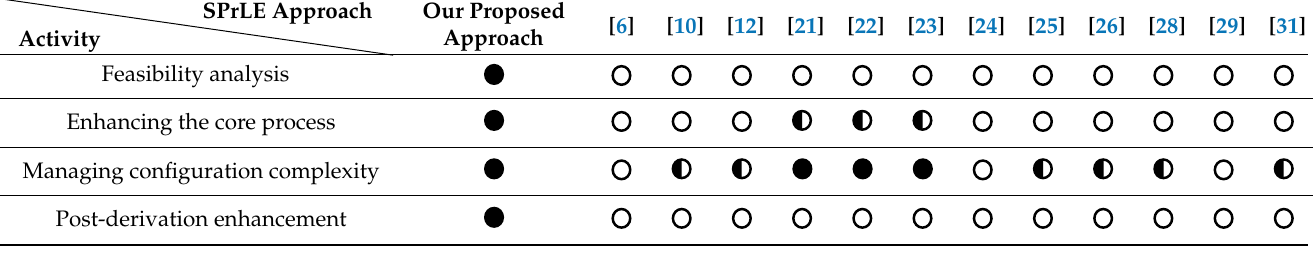
Table 7. Results of evaluating SPrLE approaches based on their support for the four SPrLE activities. SPrLE Approach